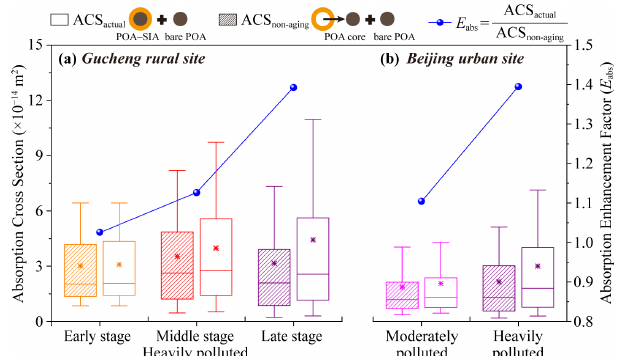
Figure 9. Box plots of light absorption cross sections (ACSs) of individual POA-containing particles (including core–shell POA– SIA and bare POA) under the actual scenario (ACS actual ) and un- coated POA particles (including POA cores without SIA shell and bare POA) under the particle non-aging scenario (ACS non-aging ) at a wavelength of 550nm and variations in the light absorption en- hancement factors ( E abs , i.e., ratio of ACS actual to ACS non-aging ) in different polluted periods at the (a) Gucheng rural site and (b) Beijing urban site. A refractive index of 1.55 − 0 i for non-light- absorbing SIA coating (Denjean et al., 2014) and 1.67 − 0.27 i for light-absorbing POA cores (Alexander et al., 2008) were adopted at a wavelength of 550nm. The box represents the 25th (lower line), 50th (middle line), and 75th (top line) percentiles; the asterisk in the box represents the mean value; and the end lines of the vertical bars represent the 10th (below the box) and 90th (above the box)